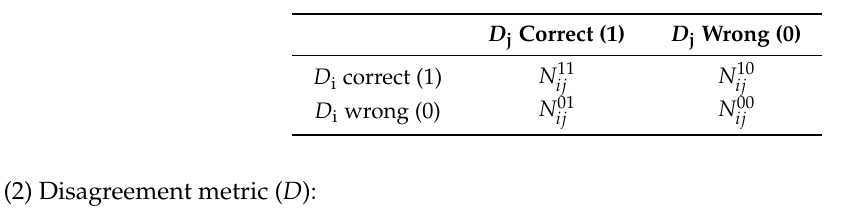
Table 1. The relationship between a pair of